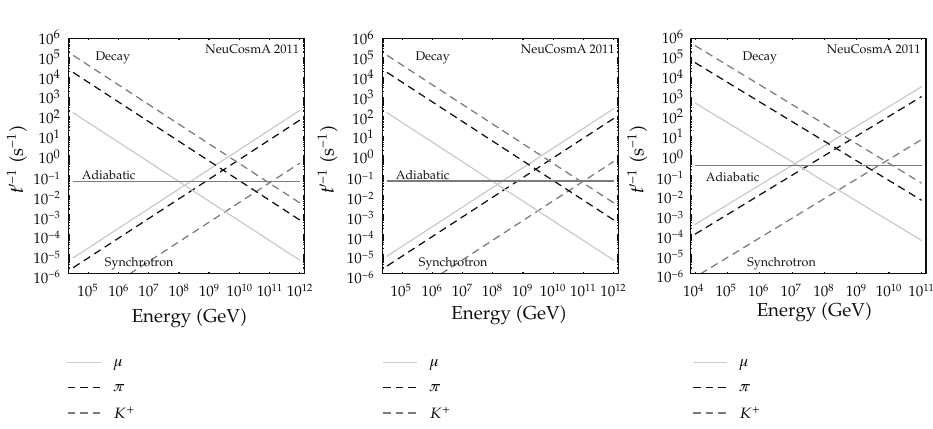
Figure 13: Expected (cid:3) time-integrated (cid:4) neutrino flux for three di ff erent GRBs (cid:3) parameters: see (cid:5) 120, 123 (cid:6) for GRB 080916C, (cid:5) 120, 124 (cid:6) for GRB 090902B, and (cid:5) 120, 125 (cid:6) for GRB 091024 (cid:4) . First row: revision of IceCube analytical method conventional fireball calculation “CFB” (cid:3) correction of shape, normalization from pion , and normalization from neutrino versus proton spectral shape c S (cid:4) , leading to the production e ffi ciency c f π revised fireball calculation “RFB.” Second row: comparison analytical (cid:3) CFB, RFB (cid:4) methods with